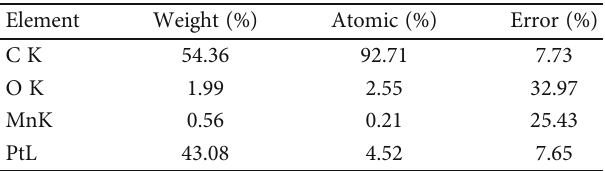
Table 2: Summary of the electrochemical data extracted from Figure